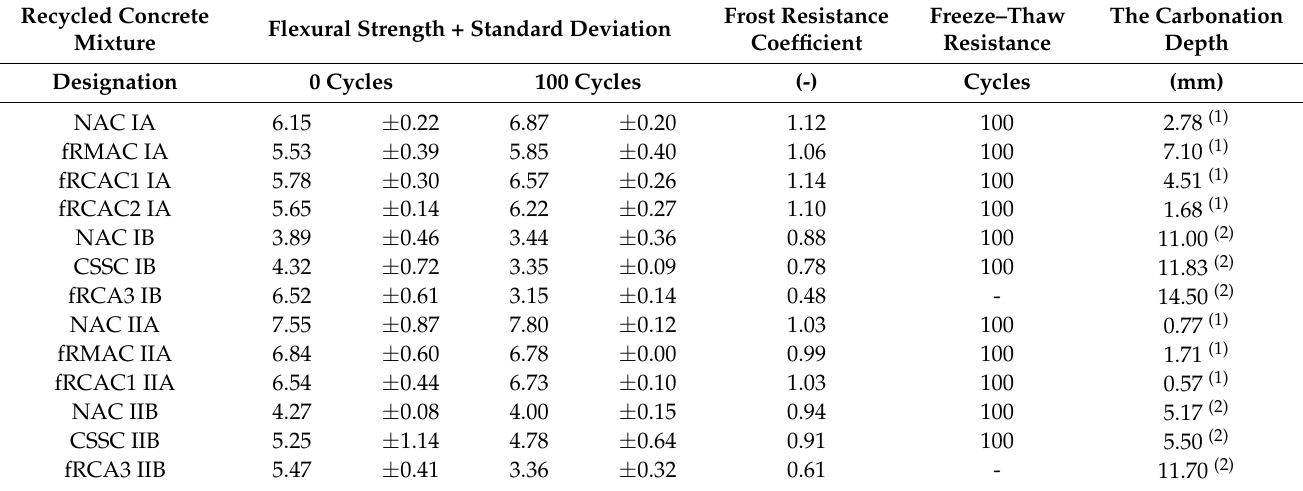
Table 8. The comparison of the flexural strength before and after freezing–thawing, the frost resistance coefficient, and carbonation depth of concrete